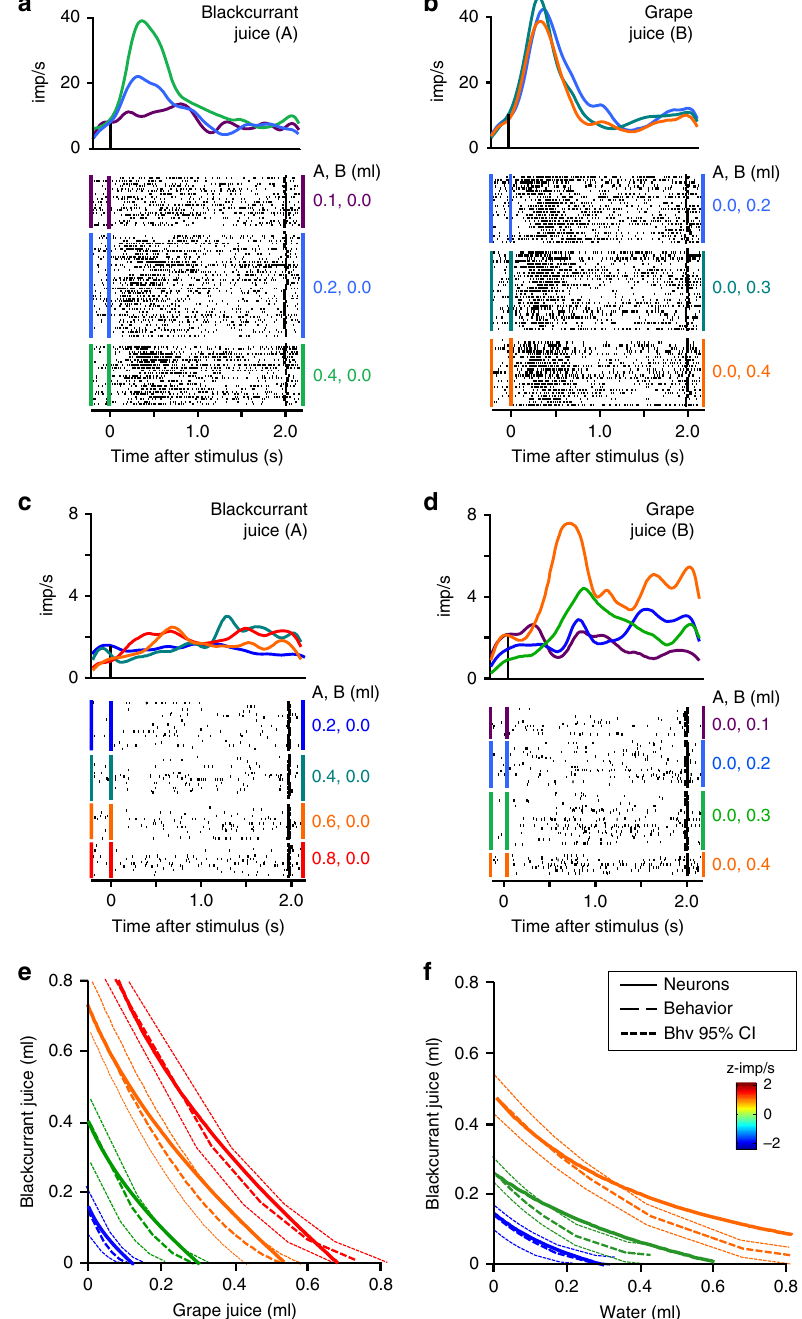
Fig. 6 Single-reward coding aggregating into scalar population signals for vectorial bundles. a Increasing responses in a single neuron with blackcurrant juice quantity (juice A, from red to green). A, B (ml) refers to respective quantity of juices A, B of the nonzero bundle chosen over the zero-reward bundle. b Invariant responses to grape juice (juice B) (same neuron as a ). c Completely insensitive activity with blackcurrant juice in a different neuron. d Increasing responses with grape juice (same neuron as c ). e, f Neuronal population ICs derived from aggregated individual, single-reward responses. Neuronal ICs (solid lines) were estimated from positively coding, nonsimultaneously recorded responses and aligned same neuronal responses to different bundles (plotted using Eq. (7b) from all single-reward coding neurons initially identi fi ed by Eqs (5) and (6). Behavioral ICs (dotted lines) were plotted from hyperbolic fi ts (Eq. (1)). ICs in e, f were estimated from respective 34 and 40 responses in any of the four task epochs from 24 and 25 single-reward positive coding neurons in Monkey A (z-imp/s: response emergence of scalar neuronal responses from vectorial bundles. At trade-off and with partial physical non-dominance, the same and a larger neuronal signal, respectively, result from oppositely varying bundle components, thus showing the integration of both components of the vectorial bundle into a scalar signal.